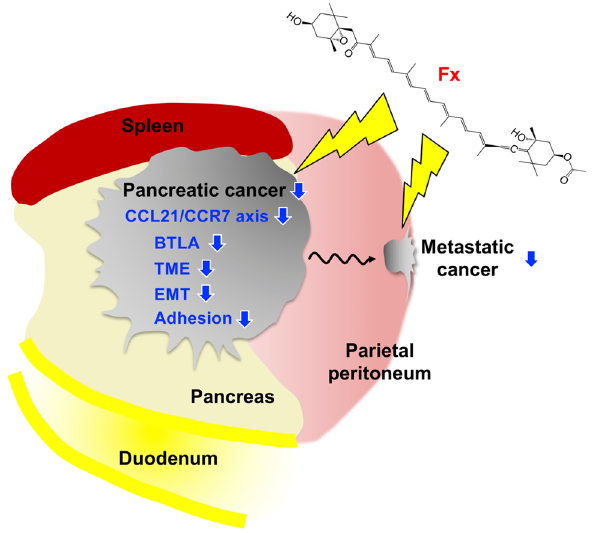
Figure 9. Possible mechanisms underlying the pancreatic cancer chemopreventive effects on C57BL/6J mice received allogenic and orthotopic transplantations of KMPC44 cells. Fx administra- tion prevents tumorigenesis on pancreatic and parietal peritoneum tissues through the suppressions of the CCL21/CCR7 axis downstream of Rho A signal, BTLA, TME, EMT, and adhesion. Blue arrows show inhibition or decrease.